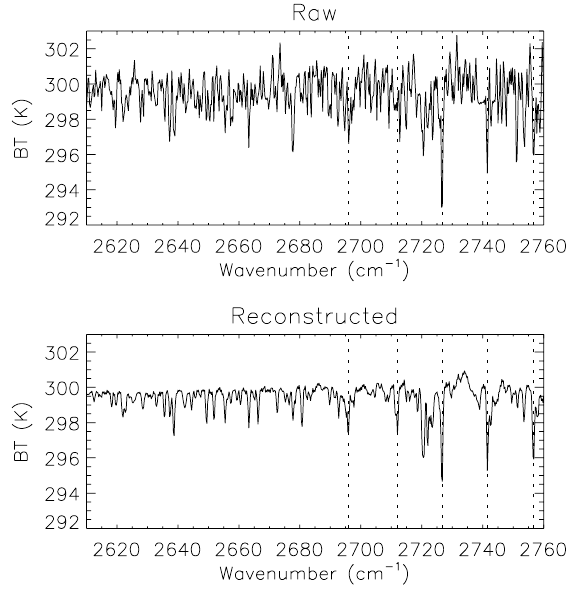
Fig. 8. Raw and reconstructed brightness temperature spectra showing methane lines in IASI band 3, for a night-time overpass. Vertical dotted lines mark the positions of methane absorption lines, from Razavi et al., 2009. The other spectral lines in the 2620 to 2690cm − 1 range (and also at 2720cm − 1 ) are HDO. Data taken from 25 August 2007, 19:38 MetOp overpass, over the Mediter- ranean (same case as Fig. 1, but well away from the biomass burn- ing